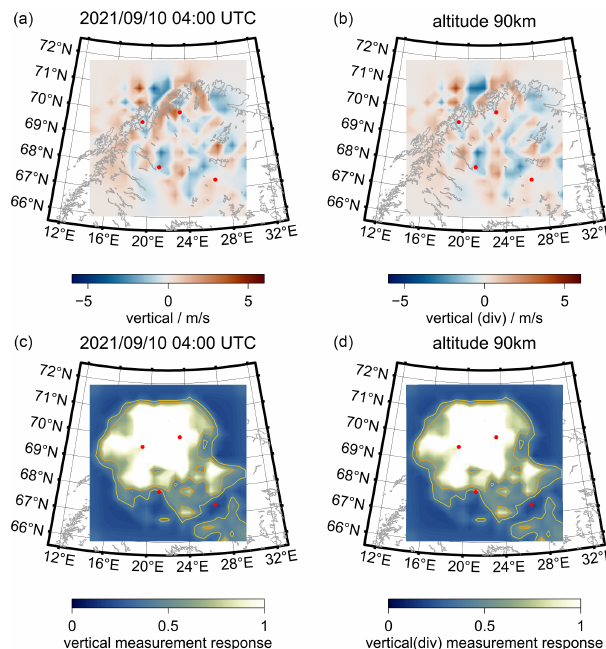
Figure 9. Corresponding vertical wind velocities (upper two pan- els, a and b ) ( a : compressible–nonstationary solution, b : incom- pressible solution) and measurement response (lower two panels, c and d ) obtained by the 3DVAR+DIV algorithm for the same period as Fig. 7. Note that the measurement response of the compressible– nonstationary vertical wind solution is dominated by the incom- pressible solution, which is used in all iterations due to the imple- mented horizontal divergence